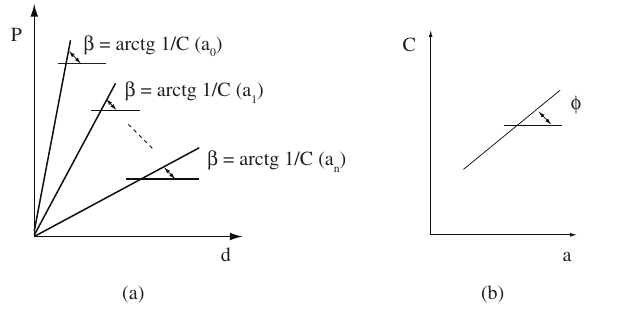
Figure 3. Obtainment of the compliance - crack length calibration curve for the double-torsion test.